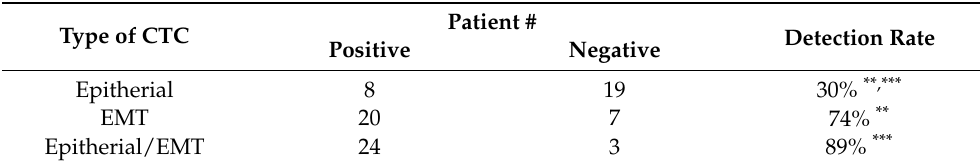
Table 2. Comparison of positive rates in case of selected by epithelial, EMT and epithelial and/or EMT CTCs.